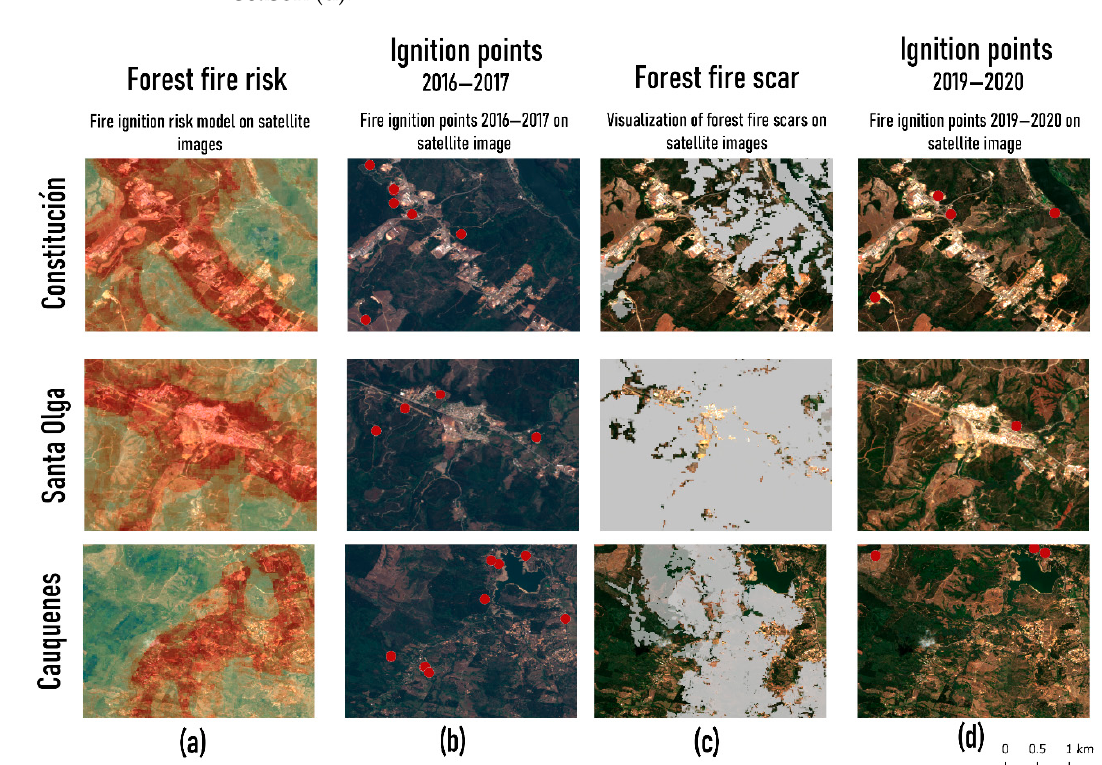
Figure 8. Matrix comparative of interface zones .